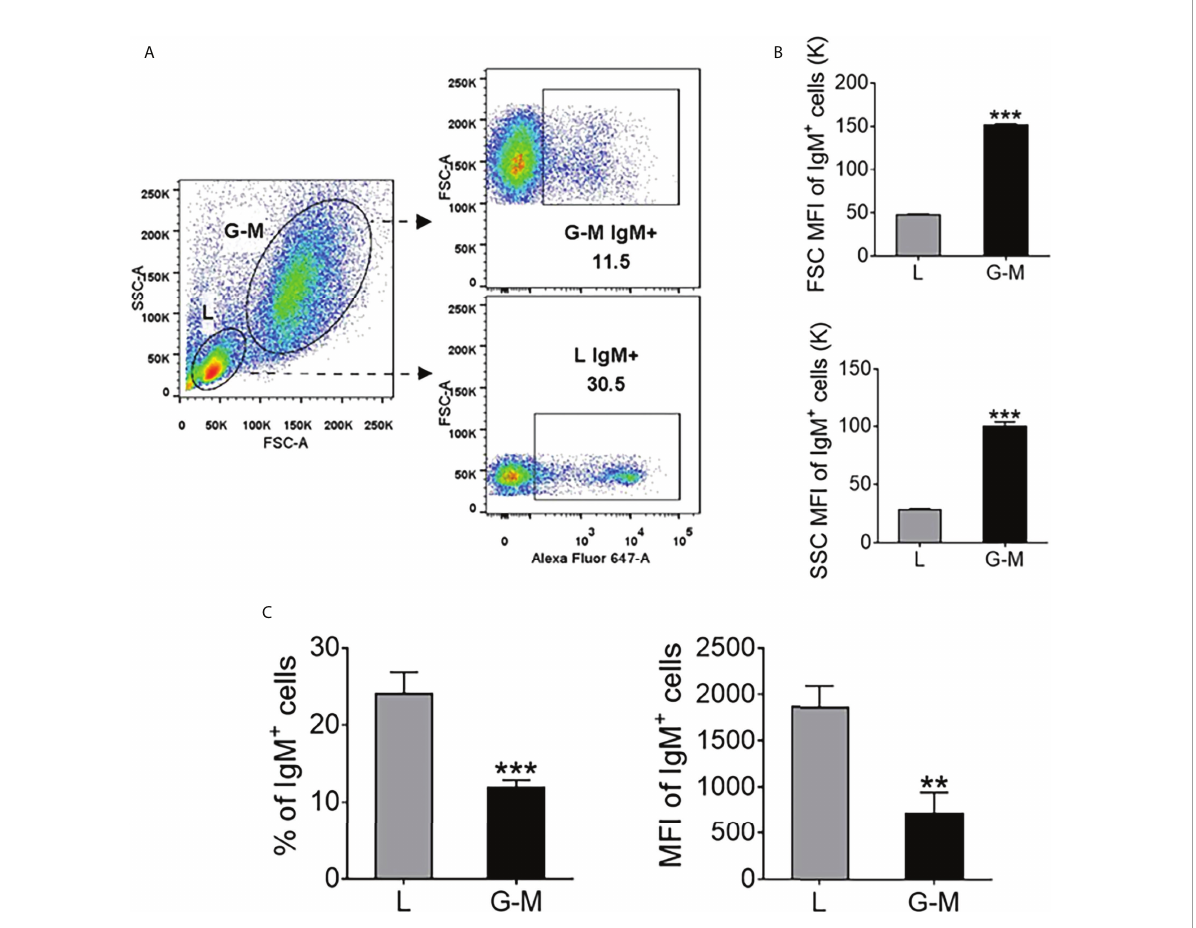
FIGURE 1 The distribution of IgM + cells in Nile tilapia anterior kidney (AK) leukocytes determined by fl ow cytometry. (A) Leukocytes were extracted from the AK with Ficoll-Paque ® PREMIUM (density 1.077 g/ml) and were stained with Alexa Fluor ™ (AF) 647-labeled mouse anti-IgM monoclonal antibody (mAb); the leukocytes were then classi fi ed into L-gate and G-M gate cells. The percentage of IgM + cells in these two gates is shown in the scatter pro fi les. (B) Forward scatter (FSC) and sideward scatter (SSC) mean fl uorescence intensity (MFI) value of IgM + cells in L and G-M gates. The MFI for each parameter was quanti fi ed and is shown on bar plots as mean value ± standard error of mean (SEM) ( n = 6 fi sh). (C) The percentage and MFI of IgM + cells in L and G-M gates. Asterisks indicate signi fi cant differences (** p ≤ 0.01 and *** p ≤